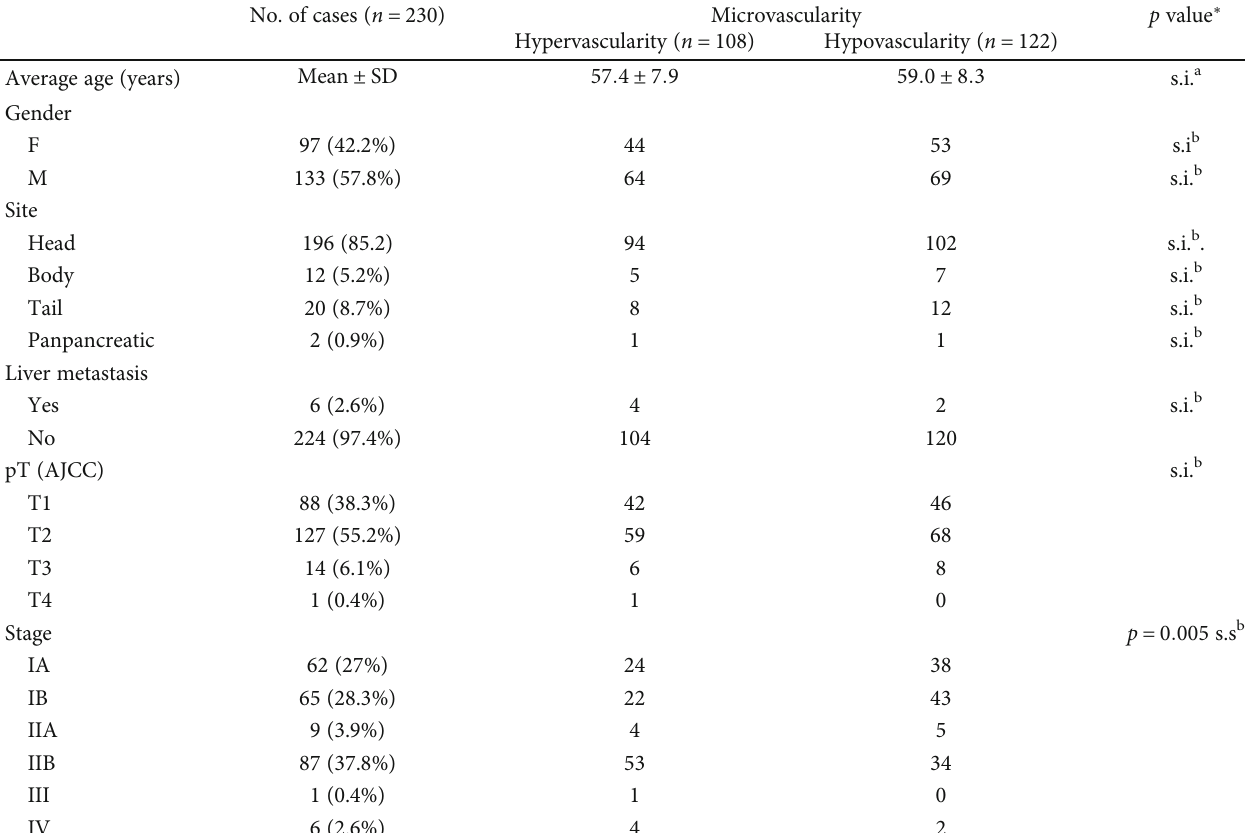
Table 2: Microvascular analysis according to number of cases and clinicopathological features.